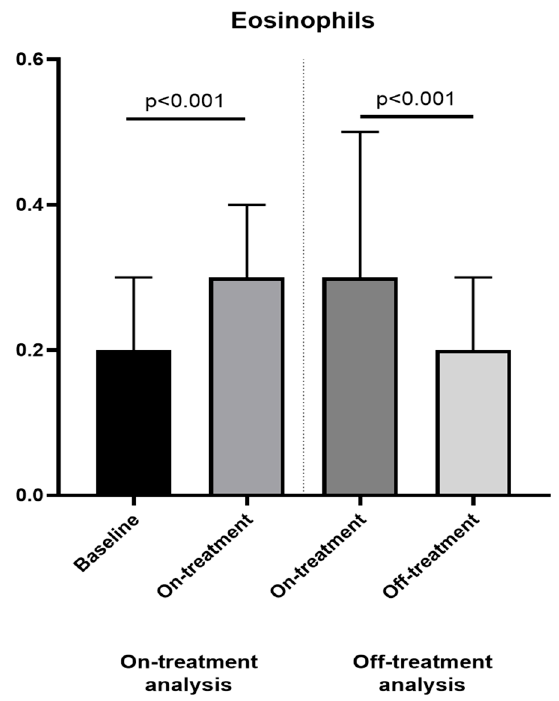
Figure 1. Changes in eosinophils between baseline, on and off-treatment analyses. We found a significant change in eosinophils between baseline and on-treatment (on-treatment analysis, left panel) and between on and off-treatment (off-treatment analysis, right panel).